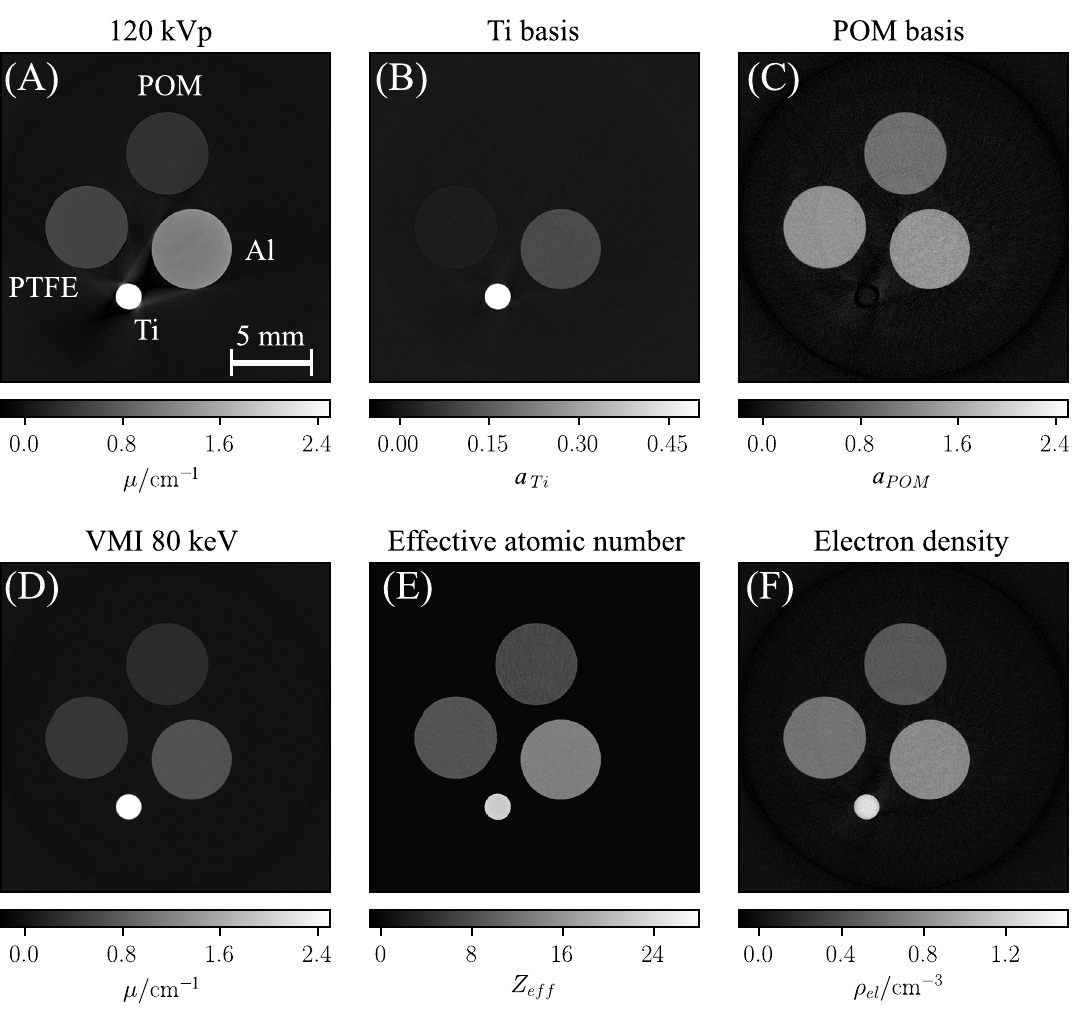
Fig 3. Spectral CT images of the phantom used to assess quantitative accuracy. While the polychromatic attenuation image (A) shows typical beam-hardening artifacts, the basis material images (B,C) are unaffected of those and yield a clear decomposition into volume fractions of Ti and POM. The VMI at 80 keV (D) alongside with the effective atomic number (E) and electron density image (F) provide quantitative information of the studied object. The accuracy of the extracted quantities is evaluated in Table 2 and Fig 4. The depicted images correspond to the mean of 10 slices of the reconstructed image volume to improve the visual appearance of potential artifacts.